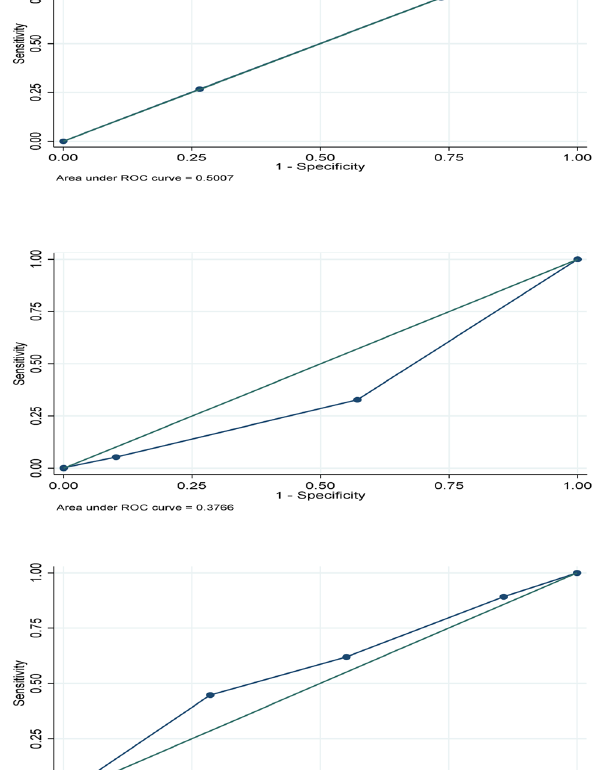
Fig. 9 ROC for NPO. Source: Researchers’ Analysis